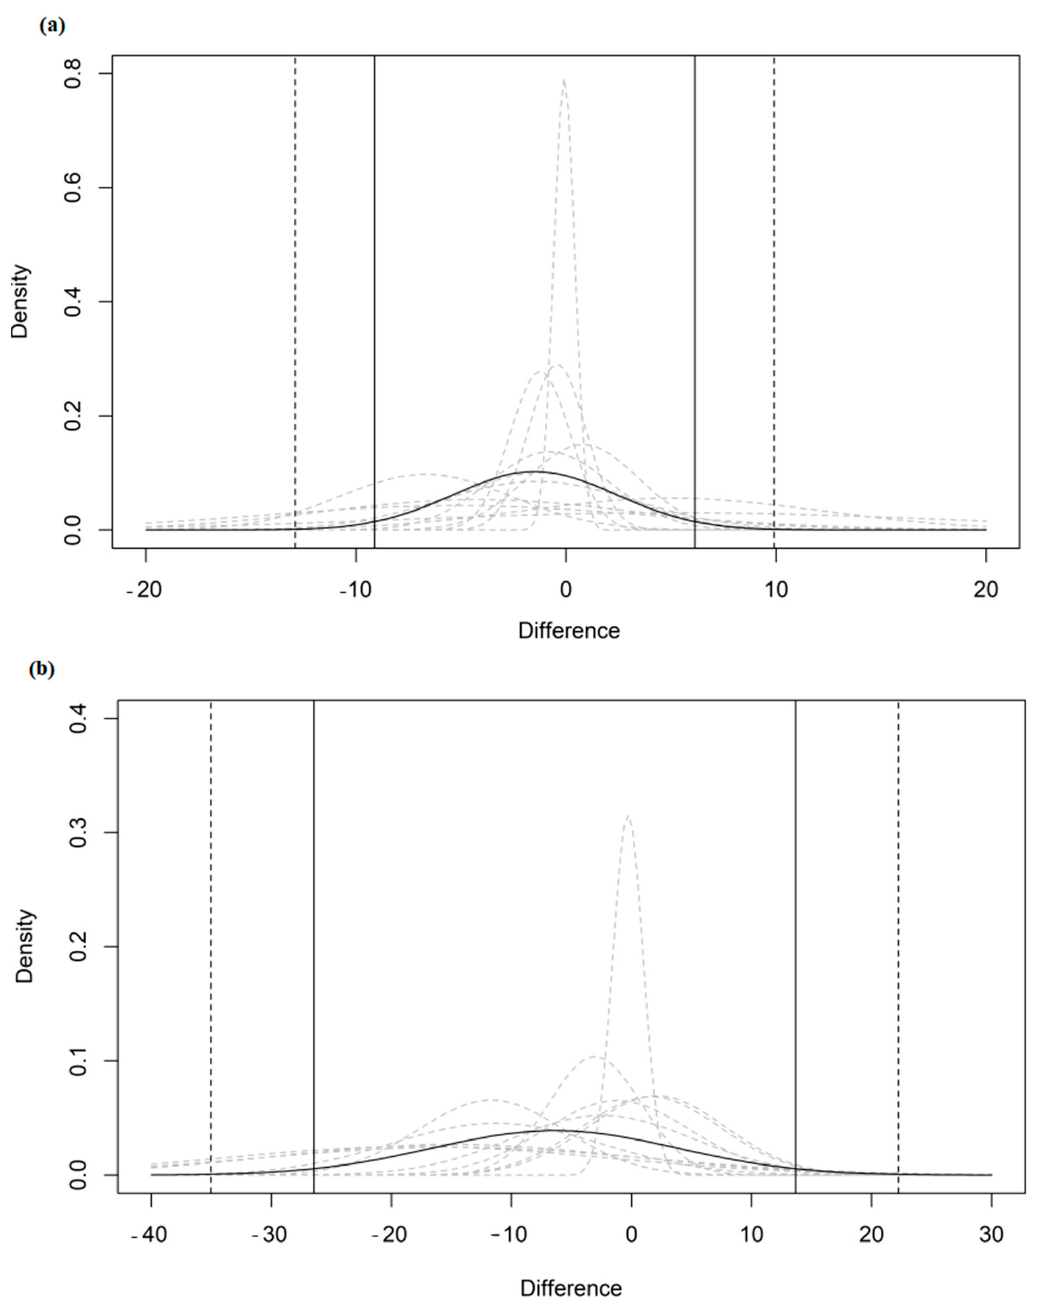
Figure 2. Pooled (black curve) and individual studies’ (grey dashed curve) estimated normal distribu- tions of the differences between AerT and FAT max expressed as mL/kg/min ( a panel) and %VO 2max ( b panel). NOTE: Vertical lines indicate the estimated pooled limits of agreement (solid vertical lines) and their outer CI 95% (dashed vertical lines).